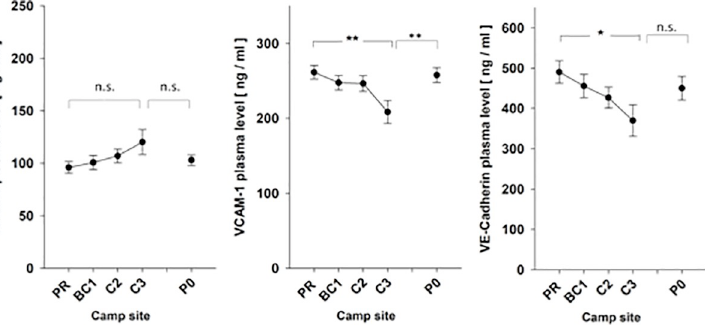
Fig 4. Levels of soluble ICAM-1, VCAM-1, and VE-Cadherin in plasma over the course of the high altitude expedition. Plasma contents of soluble ICAM-1, VCAM-1, and VE-Cadherin were quantified by specific ELISA. Shown are the means +/- SE for all individuals reaching the indicated camp sites. Statistical significance is indicated by “ � ” or “ �� ” representing p-values of p < 0.05 or p < 0.01, respectively; “n.s.” = not significant.